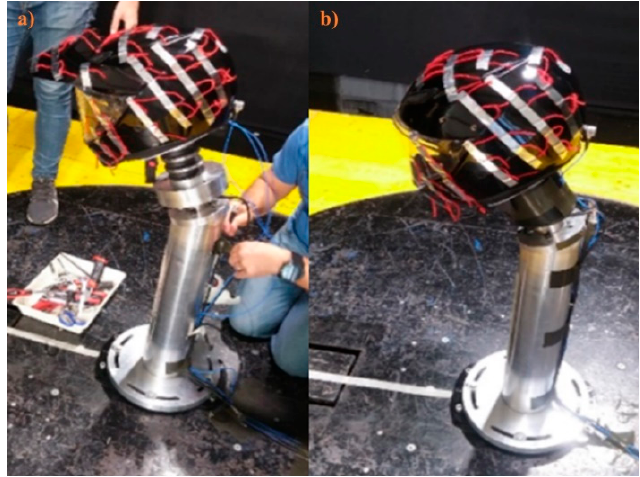
Figure 1. Type of support system used: ( a ) hybrid 3; ( b )